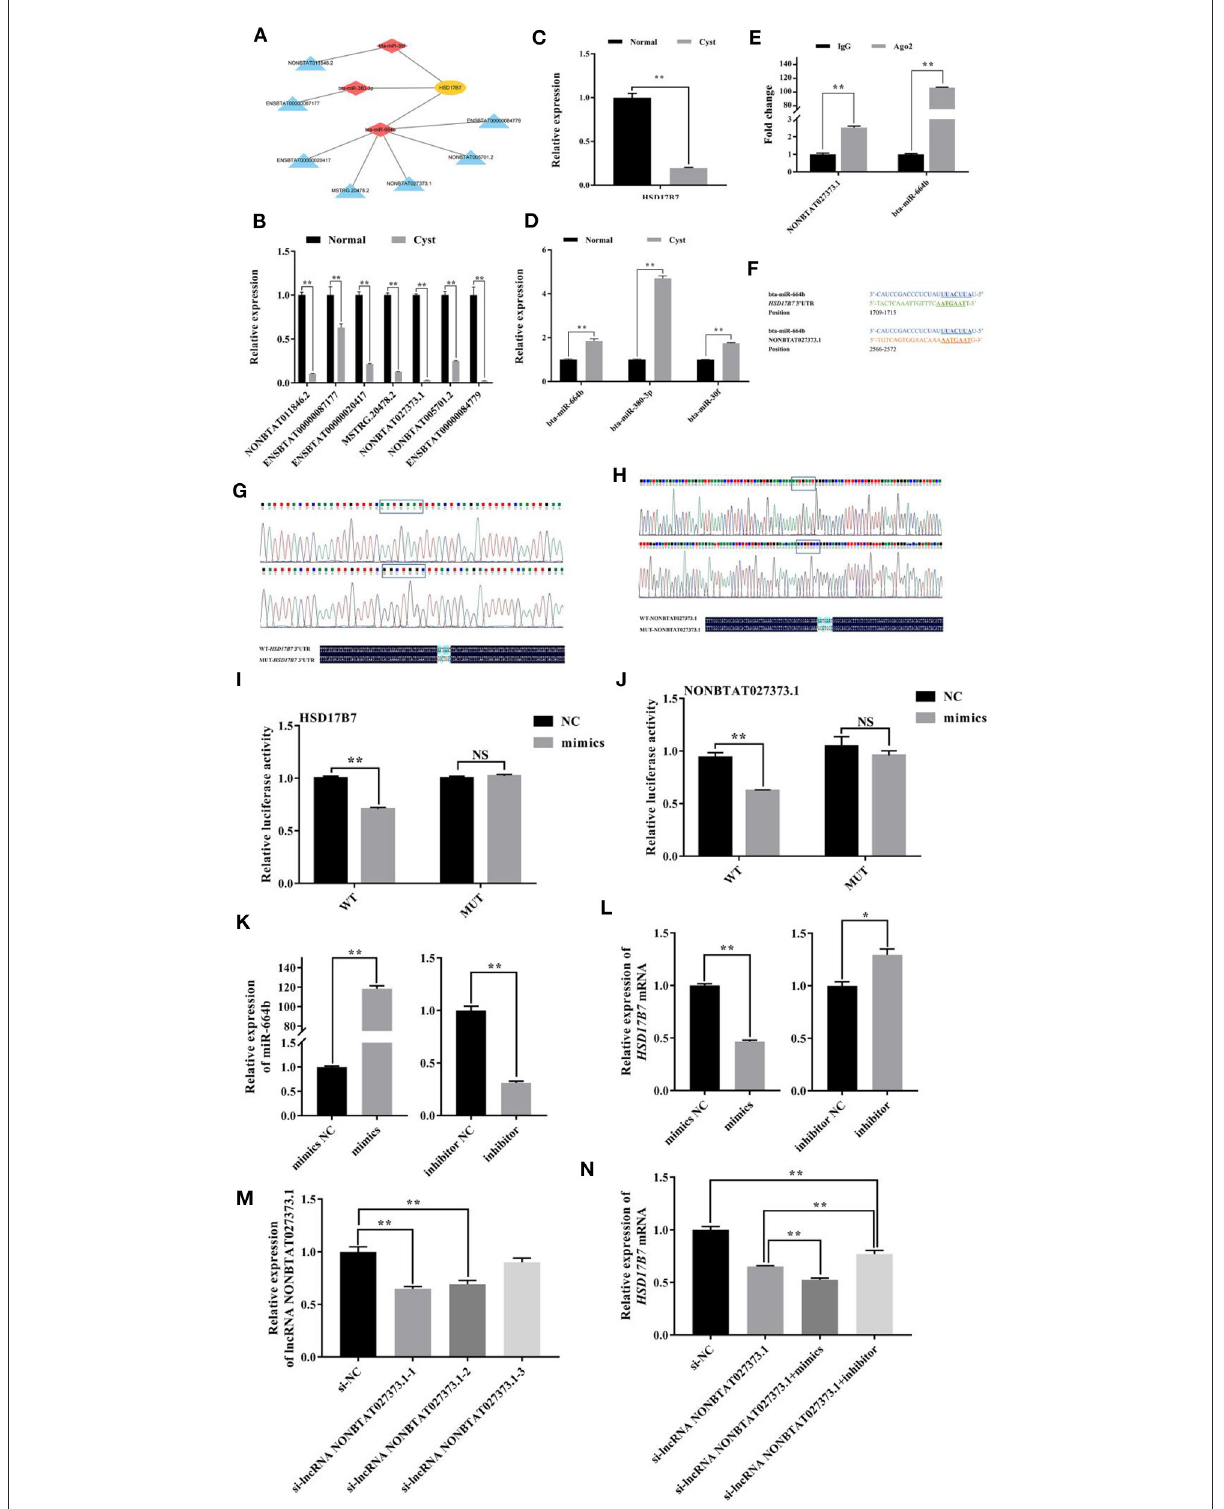
FIGURE5 Analysis of miR-664b sponge HSD17B7 3’-UTR and lncRNA NONBTAT027373.1. (A) : The networks of lncRNA-miRNA- HSD17B7 (B) : The expression of DE lncRNAs in lncRNA-miRNA- HSD17B7 networks. (C) : The expression of HSD17B7 mRNA. (D) : The expression of DE miRNAs